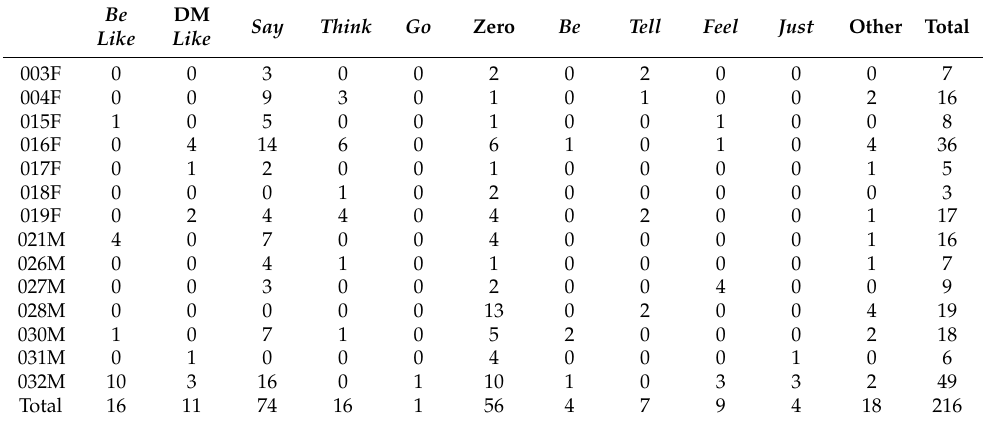
Table 6. Comparison of quotatives used by each participant in the Chinese L2